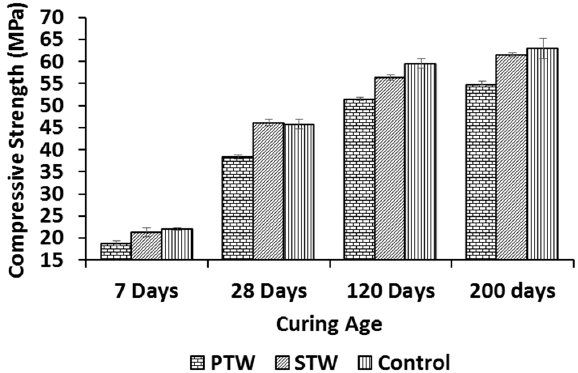
Figure 3. Influence of PTW and STW on mortar compressive strength at various wet curing age.